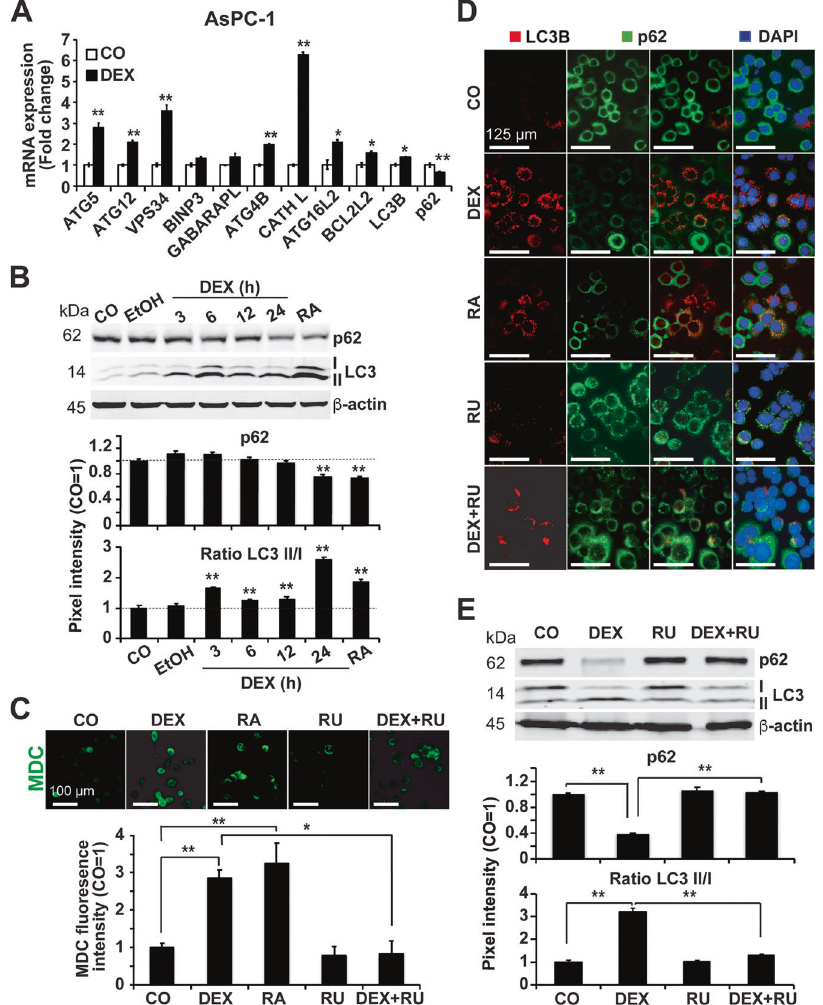
Fig. 3 GR is involved in DEX-induced formation of autophagic vacuoles. A AsPC-1 cells were treated with 1 µM DEX or with ethanol vehicle control (CO), followed by harvesting of the total RNA 24 h later. RT ‒ qPCR was performed using the speci fi c autophagy-related primers ATG5, ATG12, VPS34, BINP3, GABARAPL, ATG4B, CATHEPSIN L (CATH L), ATG16L2, BCL2L2, LC3B, and SQSTM1/p62 (p62). Gene expression was normalized to that of GAPDH, and the relative mRNA expression is shown as the fold change. The data are presented as the mean values with standard deviations. * P < 0.05, ** P < 0.01 compared to the control group. B AsPC-1 cells were incubated in medium with 1 µM DEX or 20 µM rapamycin (RA), left untreated (CO) or treated with ethanol vehicle control (EtOH) for 24 h or the indicated time points. The expression of LC3-I, LC3-II and SQSTM1/p62 (p62) was detected by western blot analysis. β -actin served as a loading control. The protein sizes in kilodalton (kDa) are given on the left. The diagrams depict the pixel intensity of the bands, which was measured using Image Studio after normalization to ® -actin. The pixel intensity of the control group was set to 1. ** P < 0.01 compared to the control group. The black dotted line represents 100%. C MDC staining of acidic vacuoles: AsPC-1 cells were cultured in medium with 1 µM DEX or 20 µM rapamycin (RA), 1 µM of the GR inhibitor mifepristone/RU486 (RU), DEX plus mifepristone/RU486 (DEX + RU), or treated with ethanol vehicle control alone (CO) for 24 h. Autophagic vacuoles were labeled with the speci fi c auto fl uorescence marker MDC (green), followed by immediate examination by fl uorescence microscopy under 200× magni fi cation. The scale bar indicates 100 µm. The MDC fl uorescence intensity was quanti fi ed by ImageJ, and the density of the control was set to 1. * P < 0.05, ** P < 0.01. D AsPC-1 cells were treated as described above. Autophagy-related protein expression of LC3B (red) and SQSTM1/ p62 (p62, green) was detected by double- fl uorescence staining under 1000× magni fi cation. The cell nuclei were counterstained with DAPI (blue). The scale bar indicates 125 µm. E AsPC-1 cells were cultured in medium with 1 µM DEX, 1 µM mifepristone/RU486 (RU), both together (DEX + RU), or with ethanol vehicle control alone (CO) for 24 h. The expression of LC3-I, LC3-II and SQSTM1/p62 (p62) was detected by western blot analysis. β -Actin served as a loading control. The protein sizes in kilodalton (kDa) are given on the left. The pixel intensity of the bands was detected by the use of ImageJ, and the means and standard deviations are shown in the diagram. * P < 0.05, ** P <